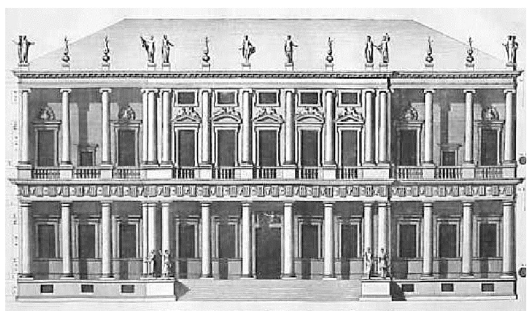
Figure 1. Palazzo Chiericati of Palladio, in Vicenza, Italy. Source: http://www.unav.es/ha/005PALA/005-bertotti/pall-bert-